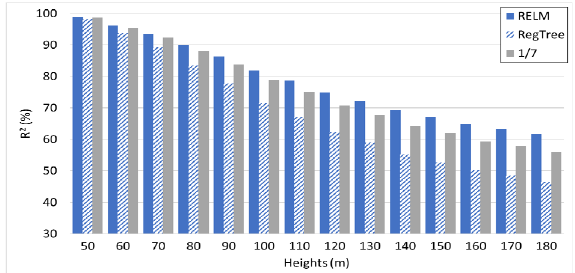
Figure 5. R 2 between different